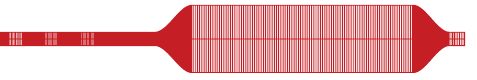
Figure 1: Experiment and numerical characteristic curves [2].